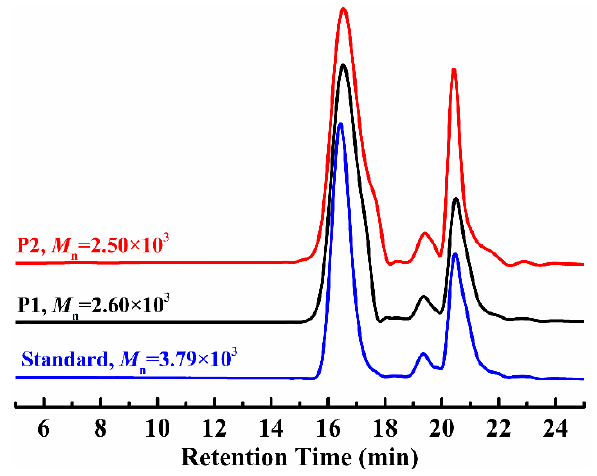
Figure 6. GPC chromatograms for P1 , P2 , and the standard ( M n = 3.79 × 10 3 g·mol − 1 ).